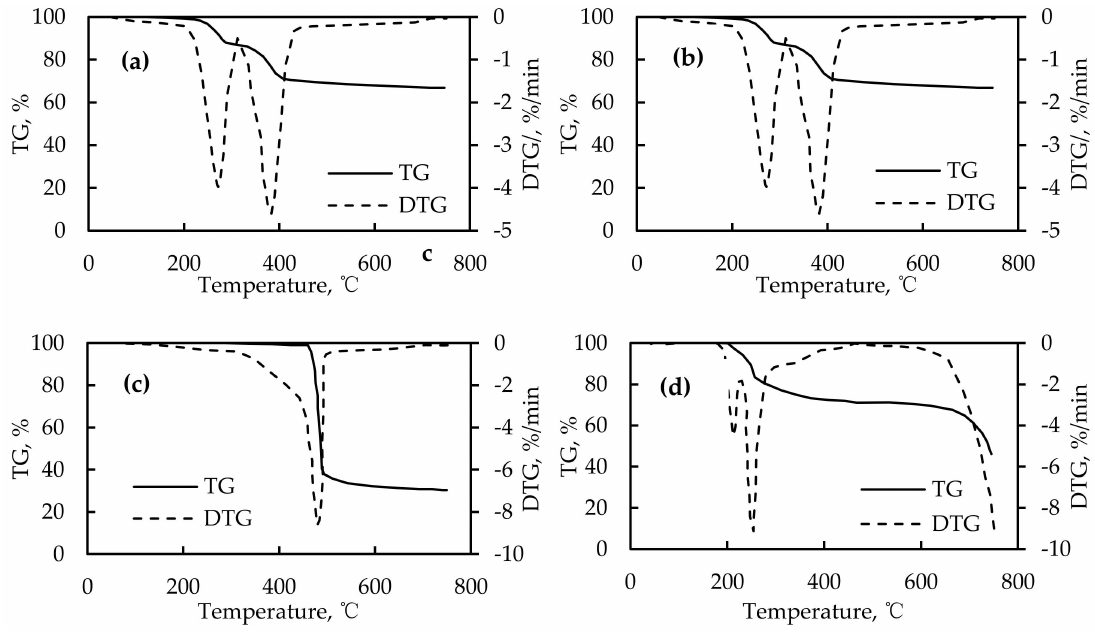
Figure 2. Thermogravimetric–di ff erential thermogravimetric (TG–DTG) curves of four fire retardants. ( a ) Aluminum hydroxide; ( b ) magnesium hydroxide; ( c ) encapsulated red phosphorous; ( d ) expanded